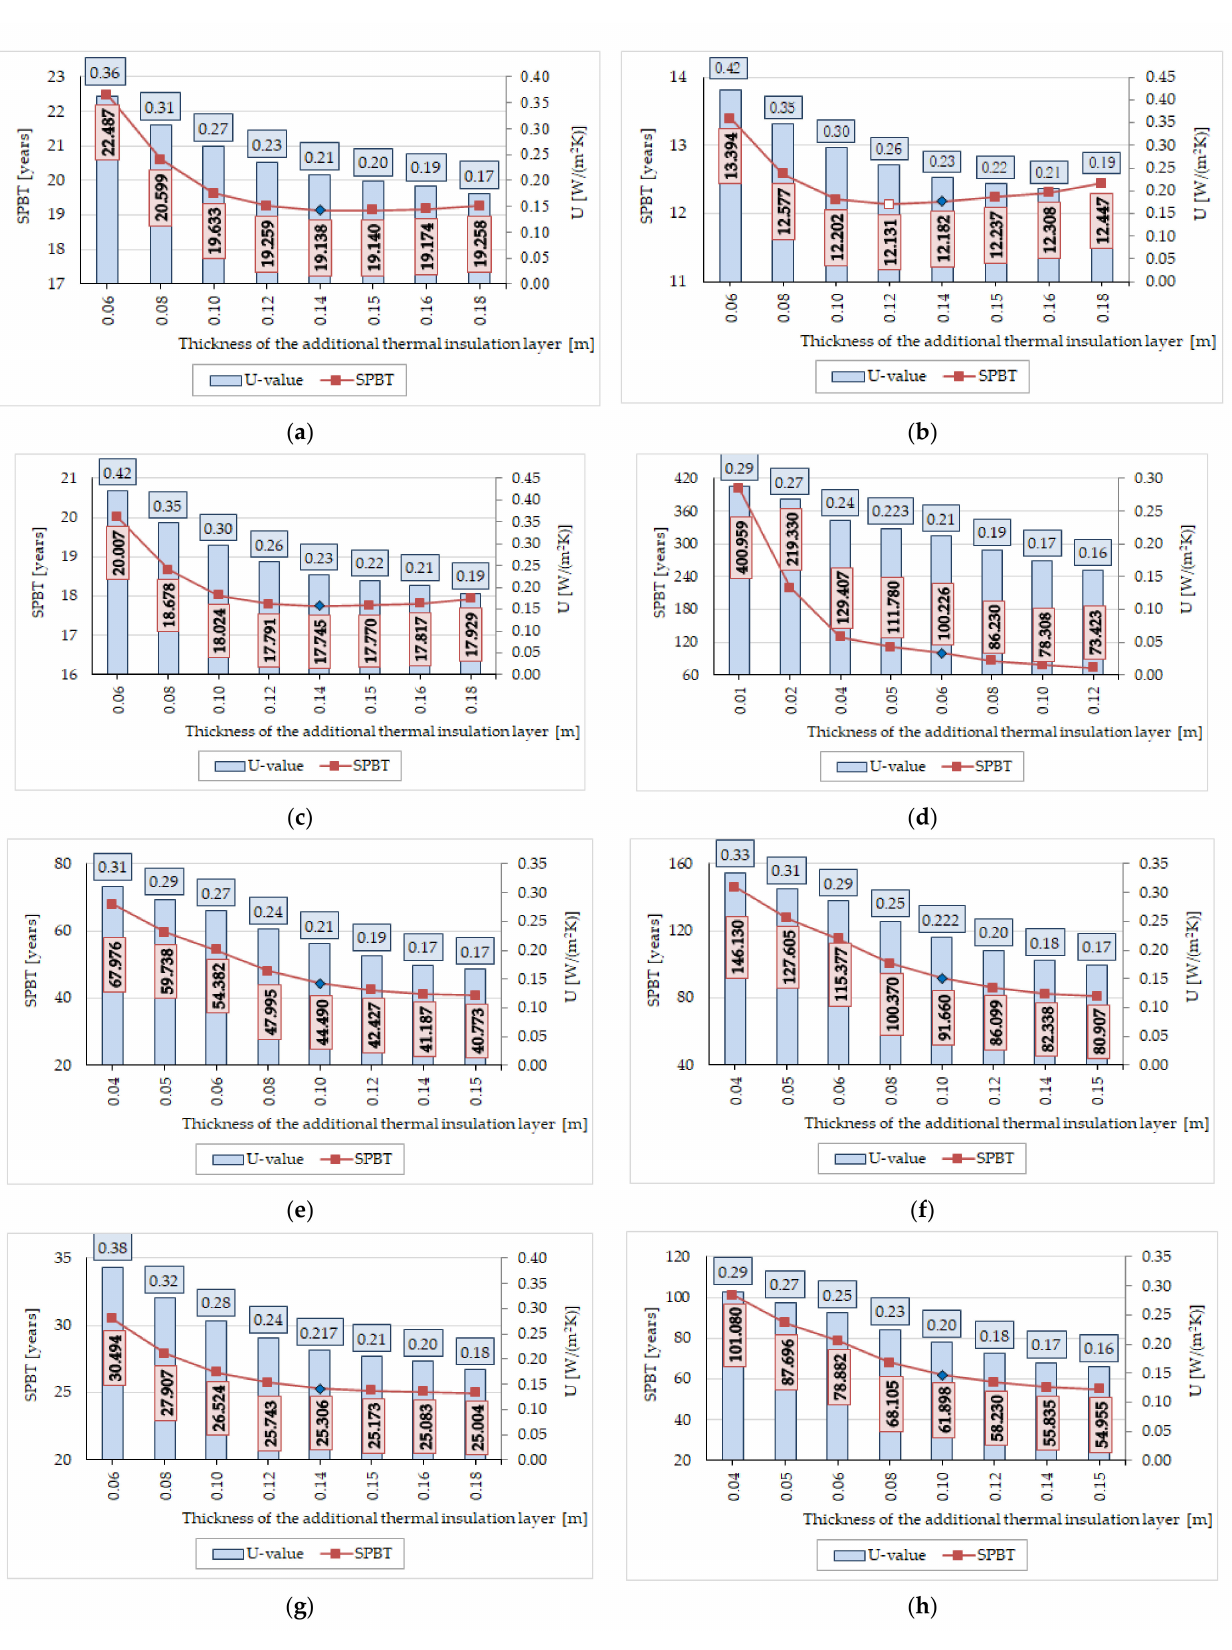
Figure 8. Results of optimization of the insulation thickness of building partitions along with an indication of the optimal, economical thickness of the thermal insulation of individual parts of